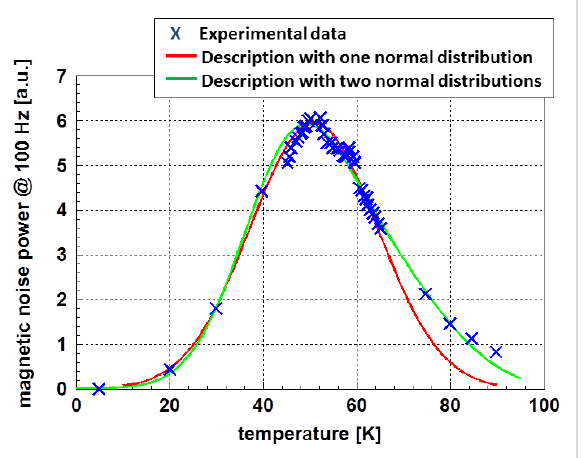
Figure 3: Experimental data for the magnetic noise power of cobalt measured at a frequency of 100 Hz according to Woods et al. [5]. The approximation using Equation 7 was made assuming one normal distri- bution for the particle sizes (red line) and a modified size distribution taking care of the tail on the side of the larger particles (green line). Using only one normal distribution, the tail on the side of the larger par- ticles is not correctly described. This deviation is minimized by the ap- plication of two normal distributions, taking care of the larger particles. The result of the latter approximation is displayed as green line.